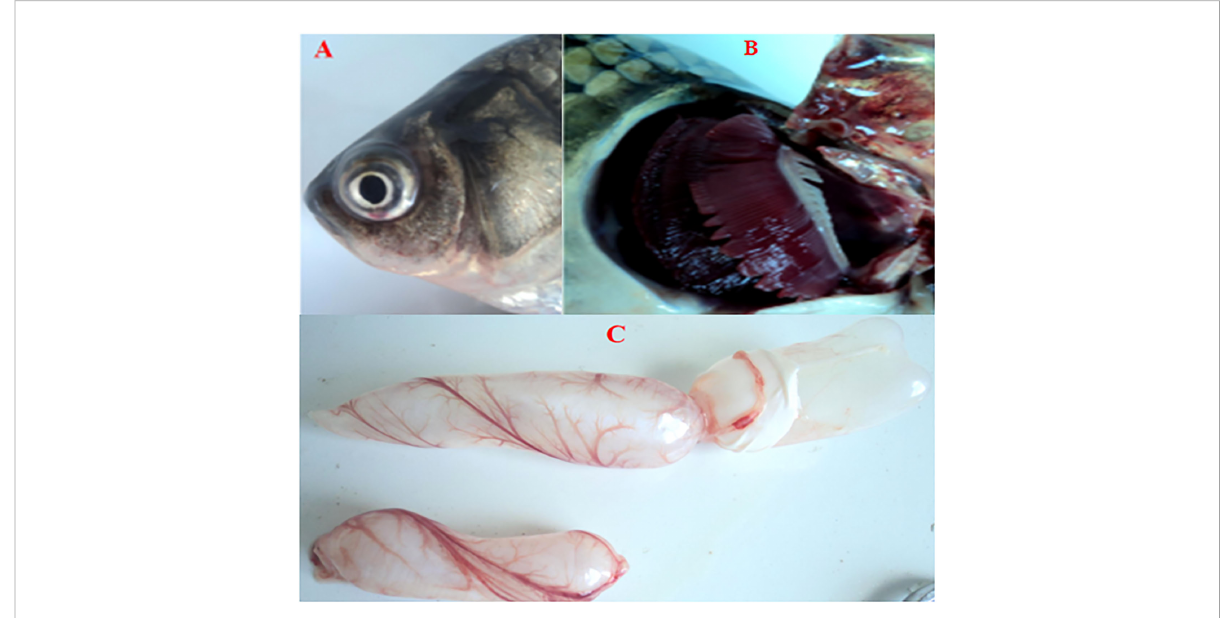
FIGURE 1 Cross-pathological signs of arti fi cially infected gibel carp ( Carassius auratus gibelio ) by Cyprinid herpesvirus 2 (CyHV-2) through the per-gill method. (A) Severe hemorrhages on the body surface and bulging eye; (B) severe hemorrhages on gills; and (C) a petechial hemorrhage presented on the bladder wall.